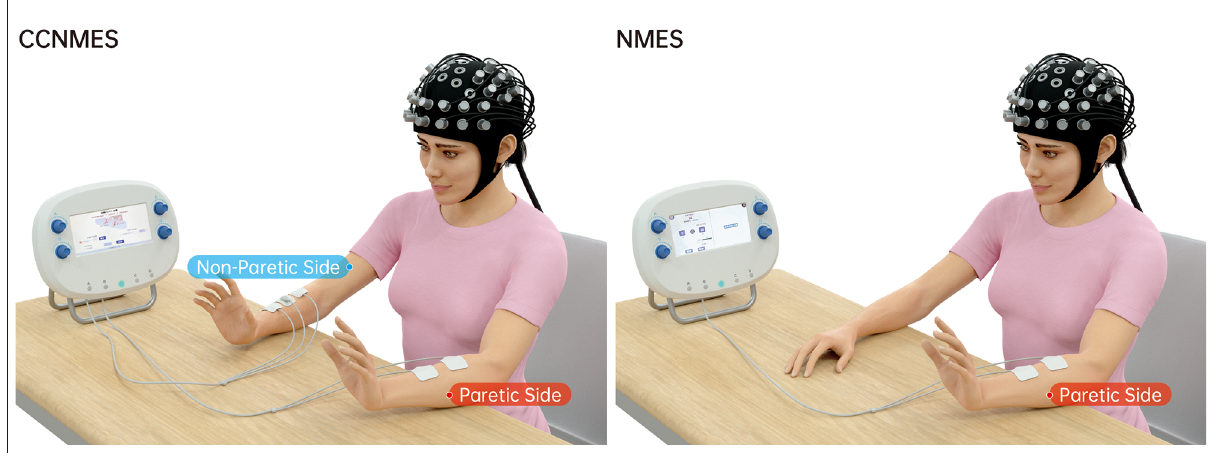
FIGURE1 Graphical representation of contralaterally controlled neuromuscular electrical stimulation (CCNMES) and neuromuscular electrical stimulation (NMES) combined with simultaneous fNIRS monitoring.